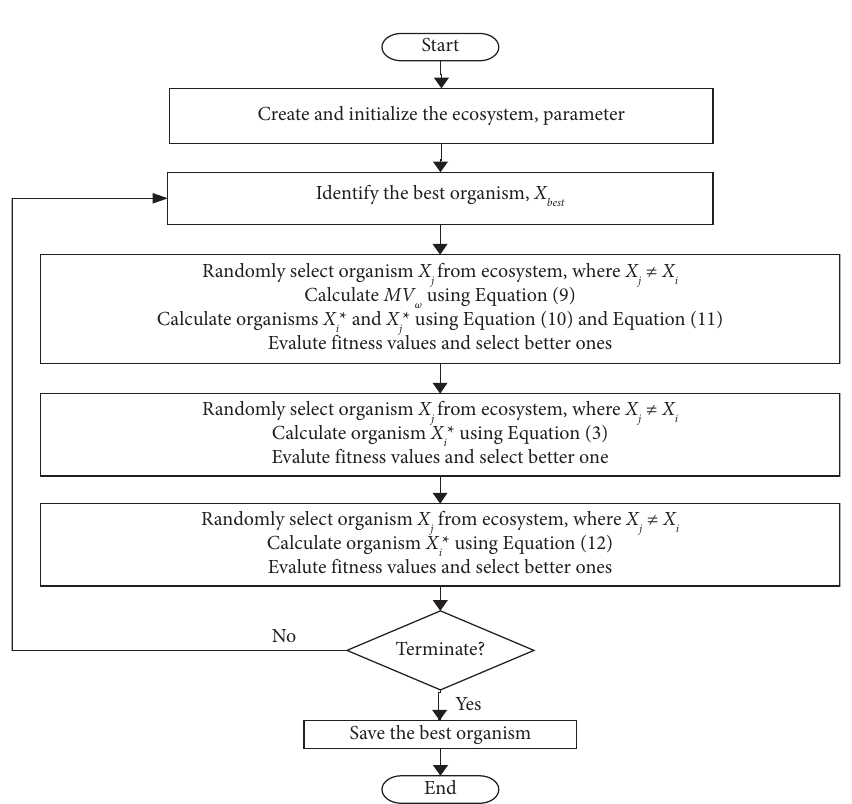
Figure 1: Flowchart of the WSOS